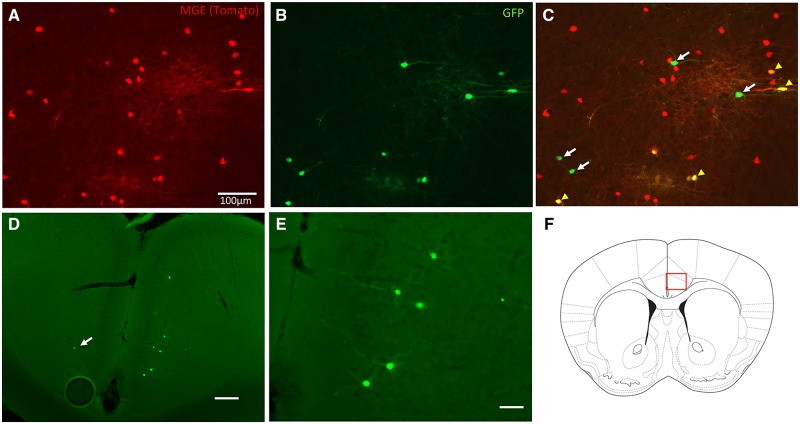

Presynaptic inputs to transplanted MGE cells. (A) Tomato- (red) and TVA-expressing MGE cells 30 days after unilateral transplant into the rACC. (B and C) Because the rabies-GFP-ΔG virus (green) is pseudotyped to express EnVa, this virus can only enter TVA-expressing starter cells (yellow cells; yellow arrowheads) and be retrogradely transported to immediately presynaptic neurons, which are only GFP-expressing (green, white arrows). (D and E) Retrogradely-labelled cells in the pACC (magnified in E) that are presynaptic to MGE cells transplanted in the rACC. Occasionally, we observed GFP+, presynaptic cells bilaterally (arrowhead in D), indicating that some MGE transplants receive bilateral inputs. (F) The schematic illustrates the location of retrogradely-labelled cells in the pACC. Scale bar = 75 μm except in D (200 μm).